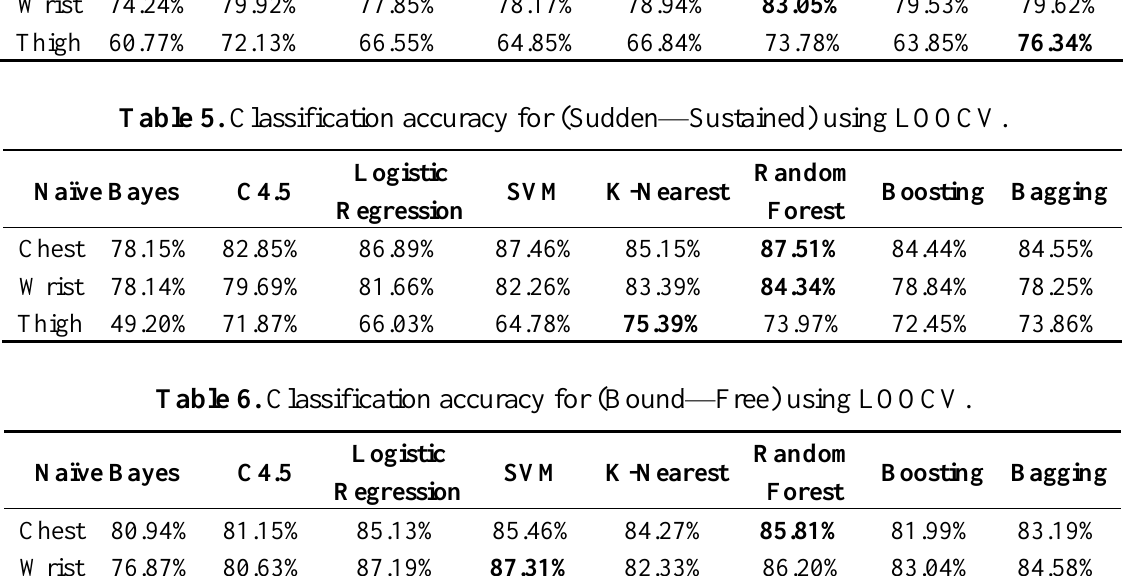
Table 4. Classification accuracy for (Strong – Light) using LOOCV. Naïve Bayes Chest